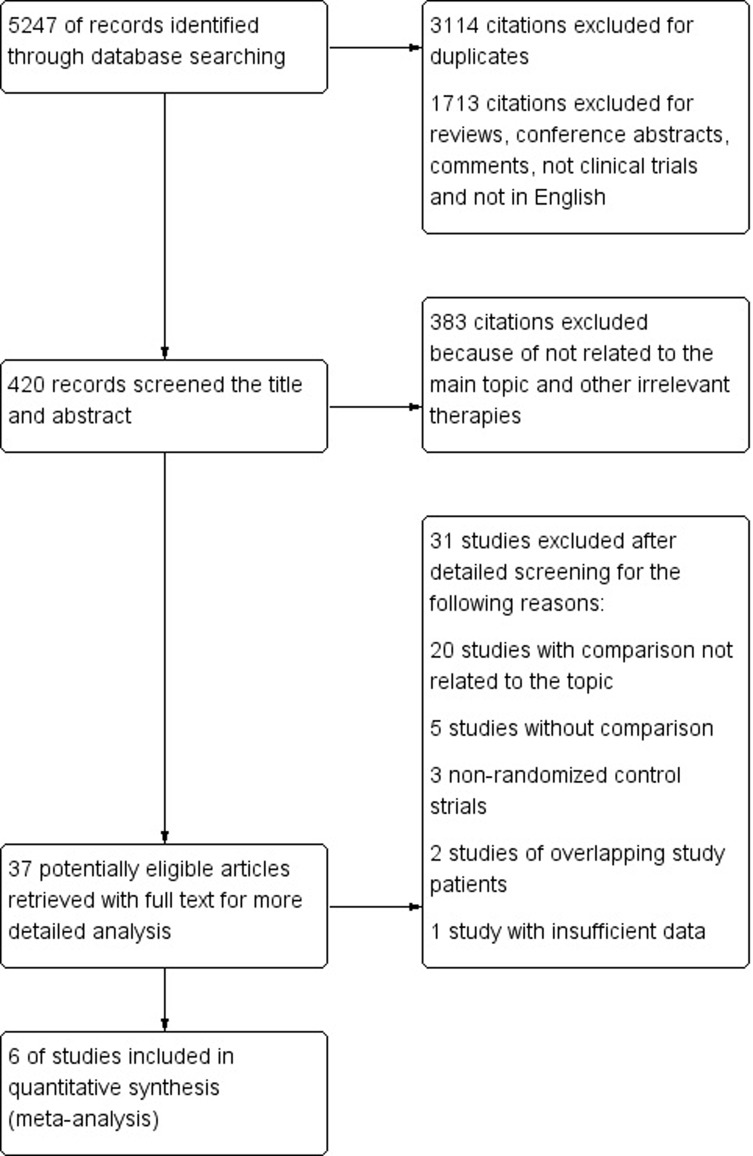
Flow diagram for selection of clinical trials included in the meta-analysis.